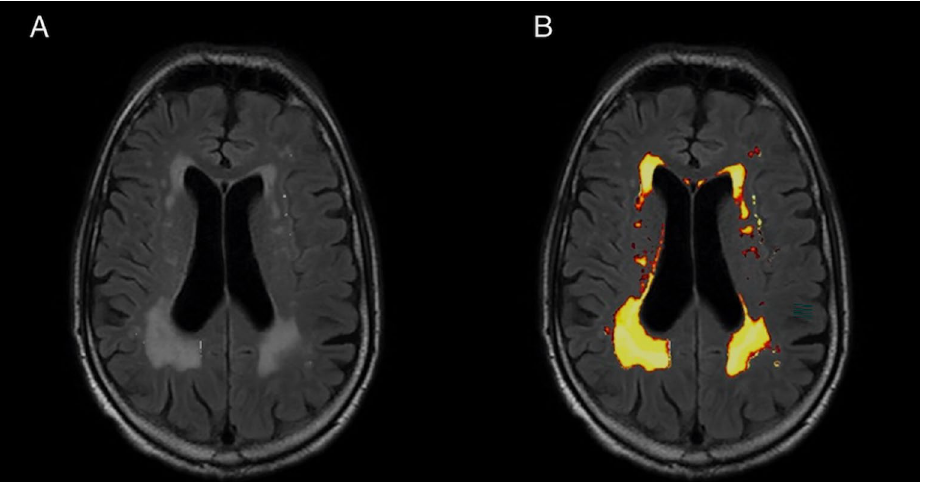
Figure 1. T2 FLAIR images from a 75-year old participant with hyperintense lesions (Fazekas 3) due to cerebral small vessel disease. ( A ) T2 FLAIR image showing multiple hyperintense white matter lesions. ( B ) Results of the white matter lesions segmentation using the lesion prediction algorithm. The white matter lesions detected by the algorithm are presented in